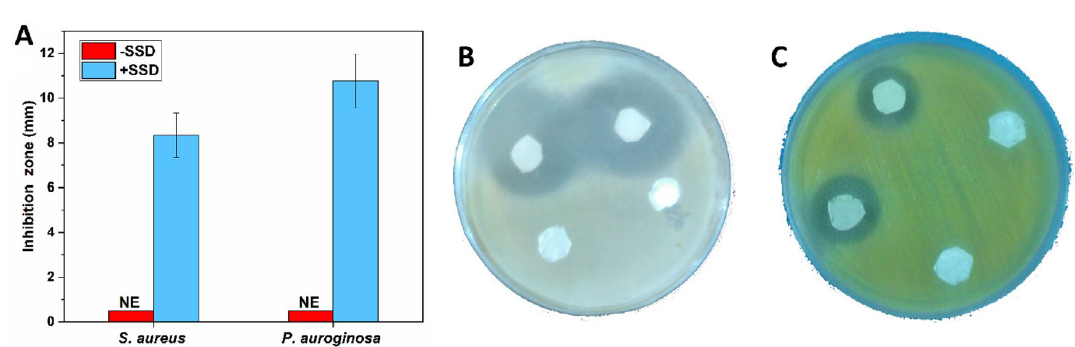
Figure 5. The antibacterial effect of the prepared nanofibrous mats against S. aureus and P. aeruginosa is shown in a bar graph ( A ). The inhibition zone against the nanofibrous mat with and without SSD in S. aureus ( B ) and P. aeruginosa is presented ( C